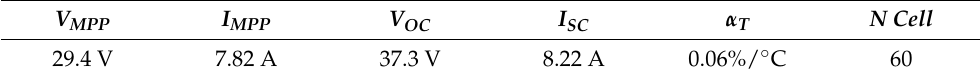
Table 1. Characteristics of the photovoltaic panel at the Standard Test Condition.